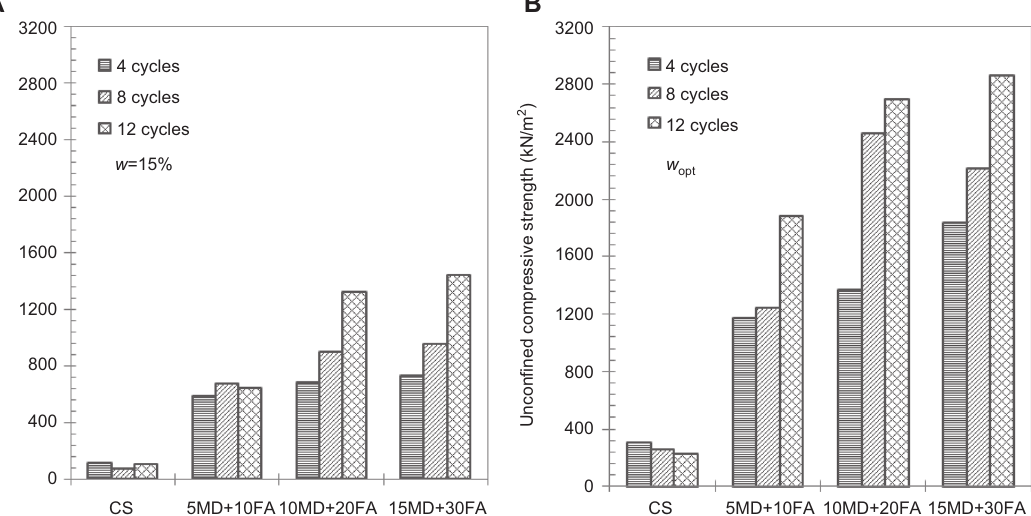
Figure 2 Unconfined compressive strengths of specimens after F-T cycles (A) at the specimens with prepared w = 15% and (B) at the specimens with prepared w opt